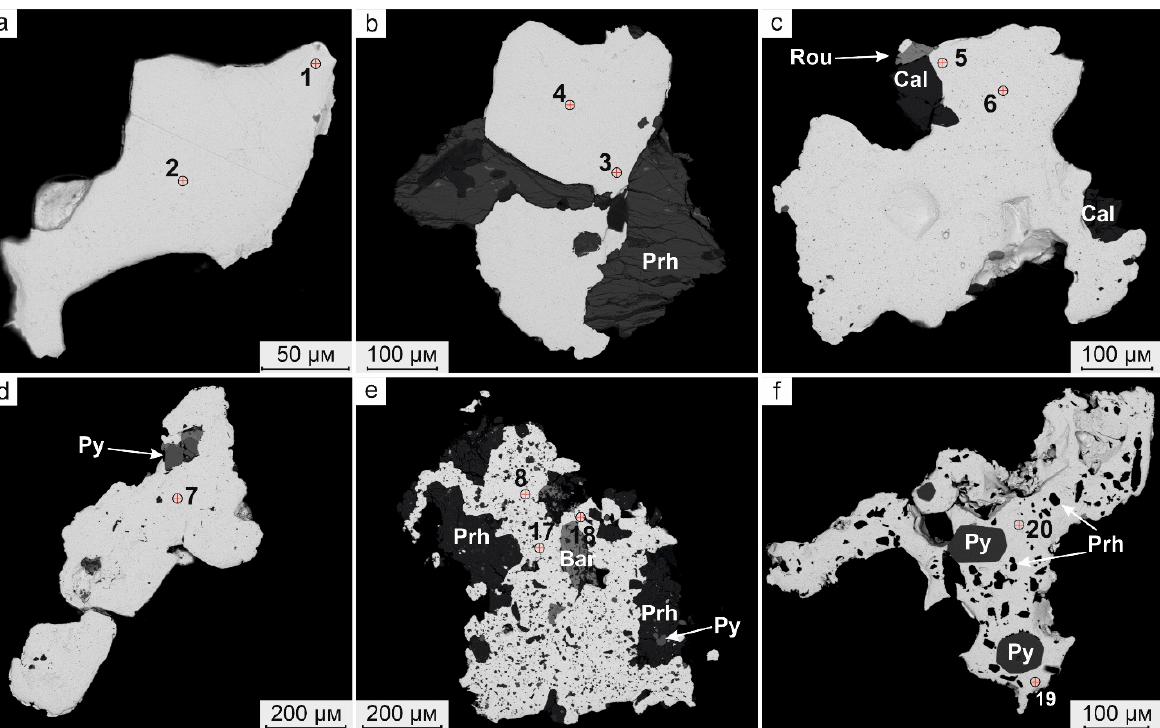
Figure 10. BSE-photo of polished sections of native gold grains. The analyses are given in the Table 3. ( a ) homogeneous gold grain; ( b ) native gold intergrows with prehnite (Prh); ( c ) native gold intergrows with calcite (Cal) and routhierite (Rou); ( d ) pyrite inclusion in native gold; ( e ) native gold with numerous inclusions of barite (Bar), prehnite (Prh) and pyrite; ( f ) euhedral inclusions of pyrite in native gold.